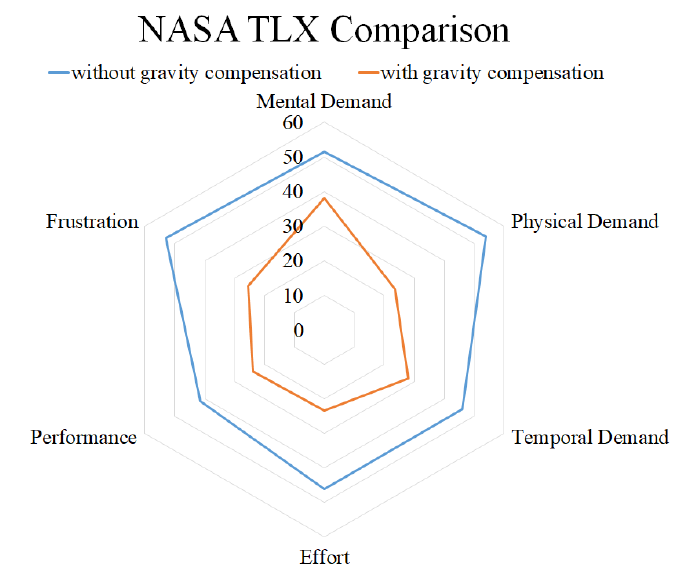
Figure 21. NASA TLX score